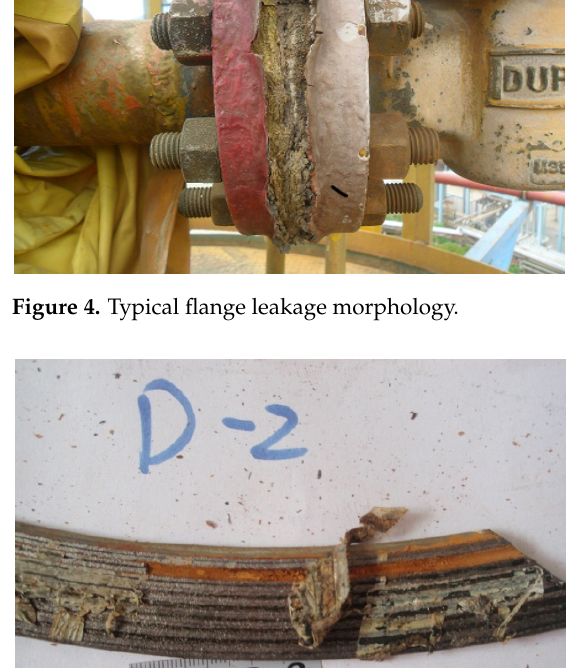
Figure 5. Typical gasket corrosion leakage morphology.